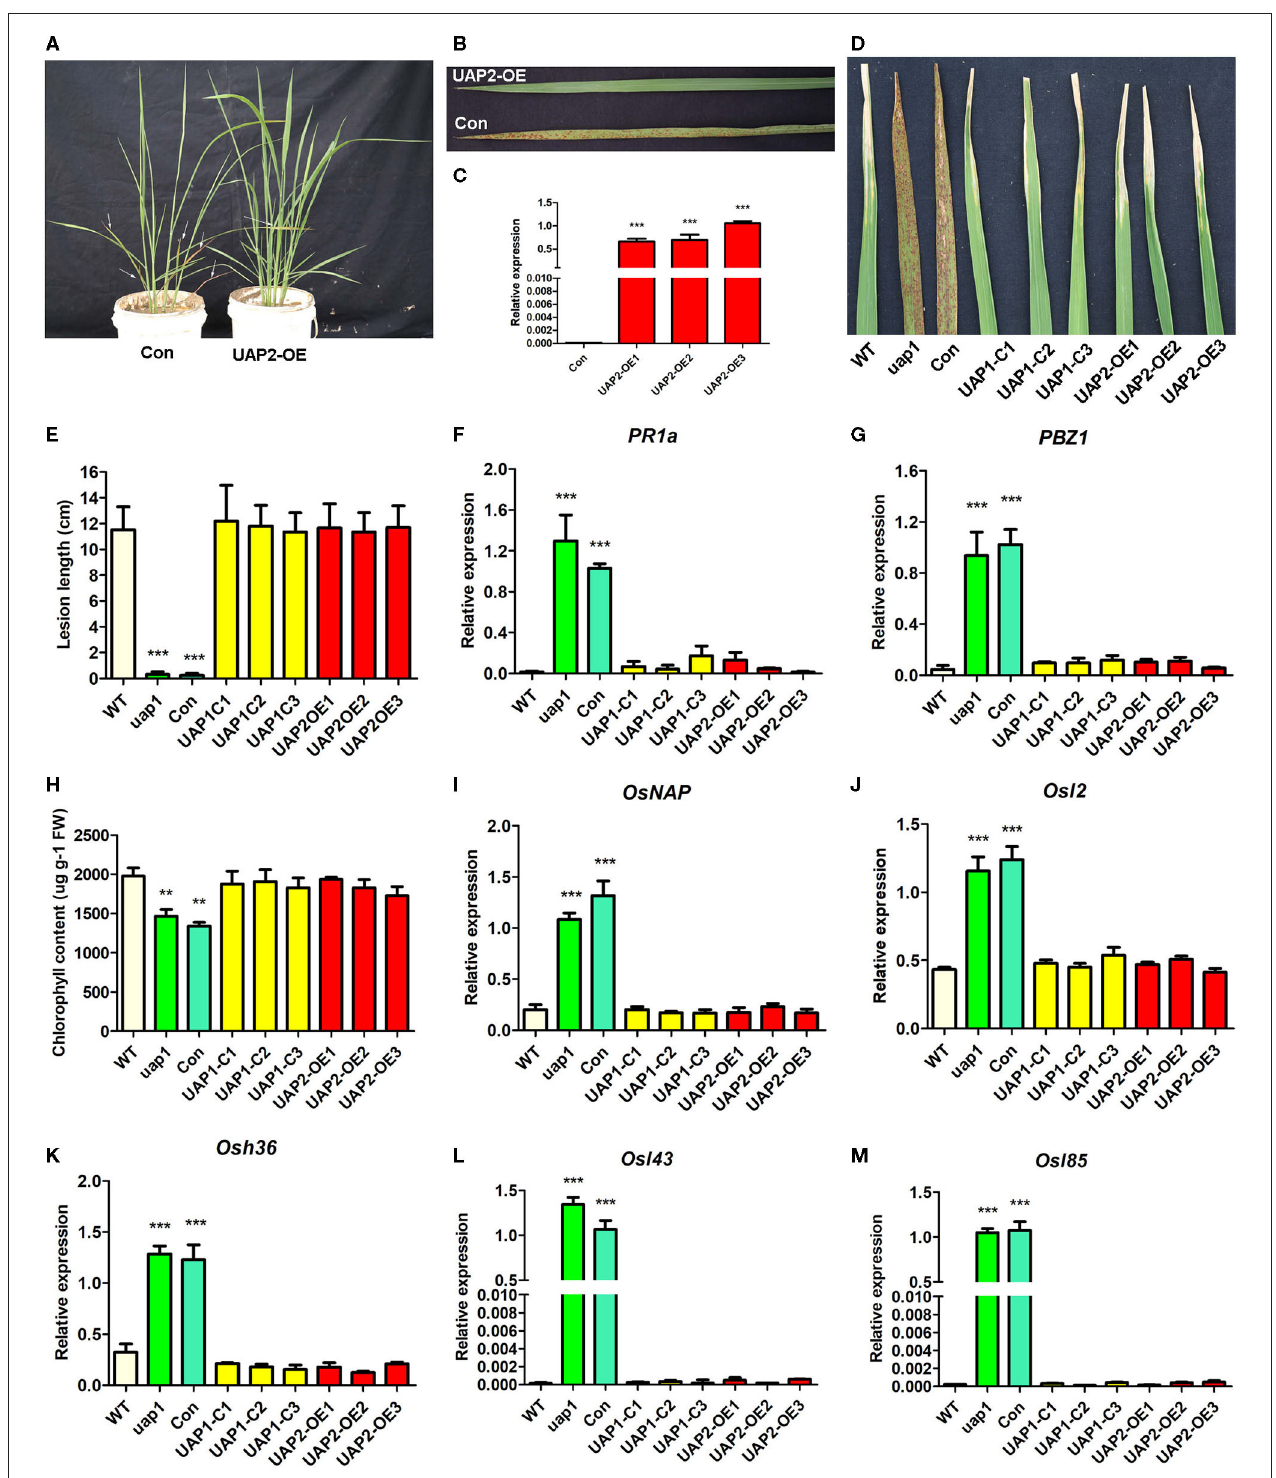
FIGURE 6 | Phenotypic and molecular characteristics for transgenic plants with the UAP2 gene rescuing the mutant phenotype of uap1 . (A) Representative transgenic plants overexpressing UAP2 (UAP2-OE) and with empty vector control (Con) at the tillering stage. Arrows indicate the leaves with the mutant phenotype. (B) Clear leaf phenotype in representative transgenic plants shown in (A) . (C) Relative expression of the UAP2 gene in three representative transgenic plants overexpressing UAP2 (UAP2-OE1, UAP2-OE2, and UAP2-OE3) and control transgenic plant with empty vector (Con). Data represent the mean ± SD of three biological replicates, and the asterisk indicates the statistically significant difference of overexpression samples compared with Con (*** P < 0.0005, Student’s t -test).